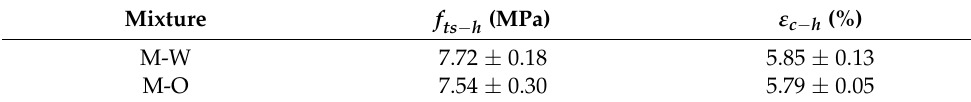
Table 7. Tensile strength and tensile strain capacity at post-healing.